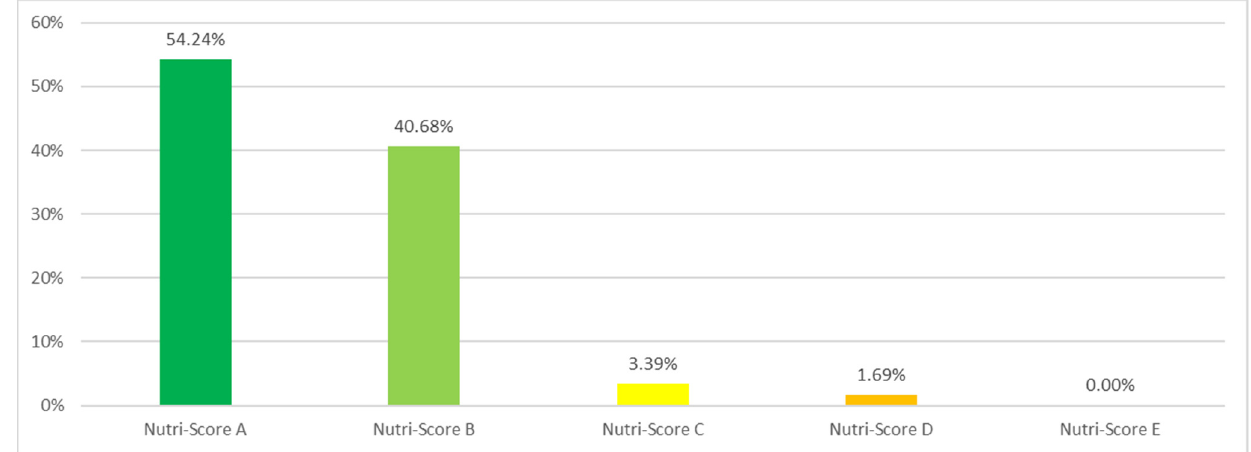
Figure 3. Distribution of Nutri-Score groups in products that meet the criteria of the WHO Europe Nutrient Profile Model ( n = 59).